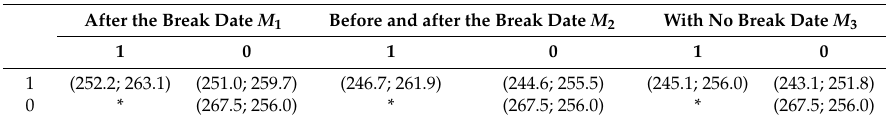
Table 1. Trend model comparison with the Akaike information criterion (AIC) and Bayesian information criterion (BIC). Numbers 1 and 0 are the polynomial degrees used in trend models (0 for a stationary model and 1 for a linear model).